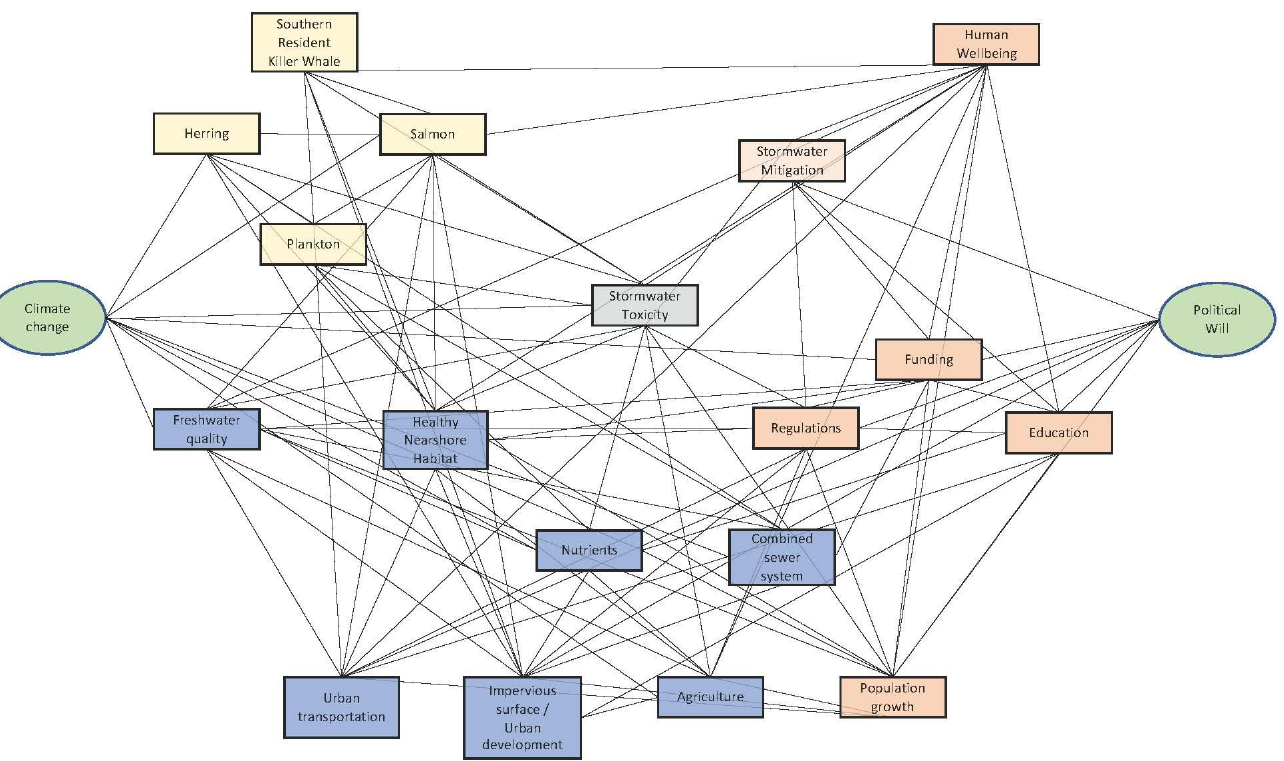
Figure 3. The aggregate mental model of stormwater experts showing connections among ecological resource units (yellow), the resource system (green), governance and actors (orange), and key externalities (blue). Details of the linkages among nodes can be found in Figure A1.